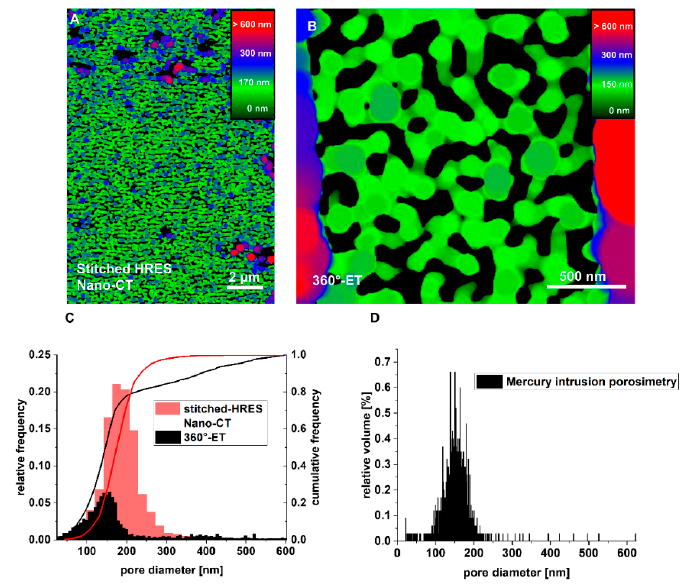
Figure 6. Pore size evaluation utilizing the maximum sphere inscription (MSI) technique. ( A ) Color map representation of a virtual slice through the stitched-HRES nano-CT data (sample rou- tine 1) with pore diameters ranging from green to red representing 0–600 nm. ( B ) Color map representation of a virtual slice through the 360°-ET data (sample routine 1) using the same color scale. ( C ) PSD (left y-axis, bar chart) determined from the 360°-ET and stitched-HRES nano-CT 3D reconstructions using the MSI method. The cumulative frequency curves (right y-axis) describe the number of pores summed up to the corresponding pore diameter divided by the total number of particles. ( D ) PSD of the unloaded support framework Trisopor ® 150 (porous silica) using the mercury intrusion technique.